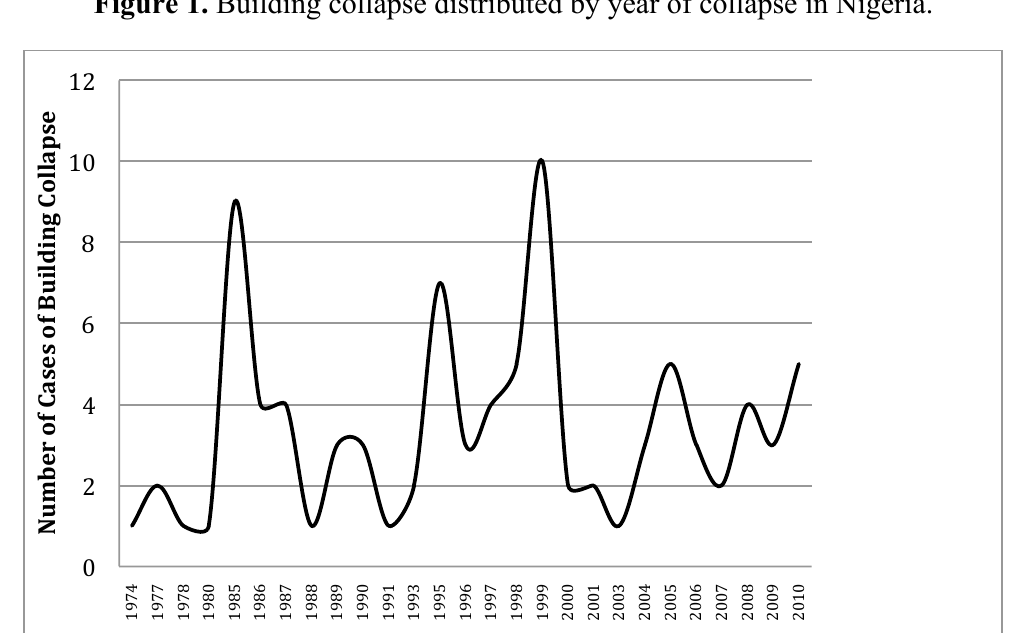
Figure 1. Building collapse distributed by year of collapse in